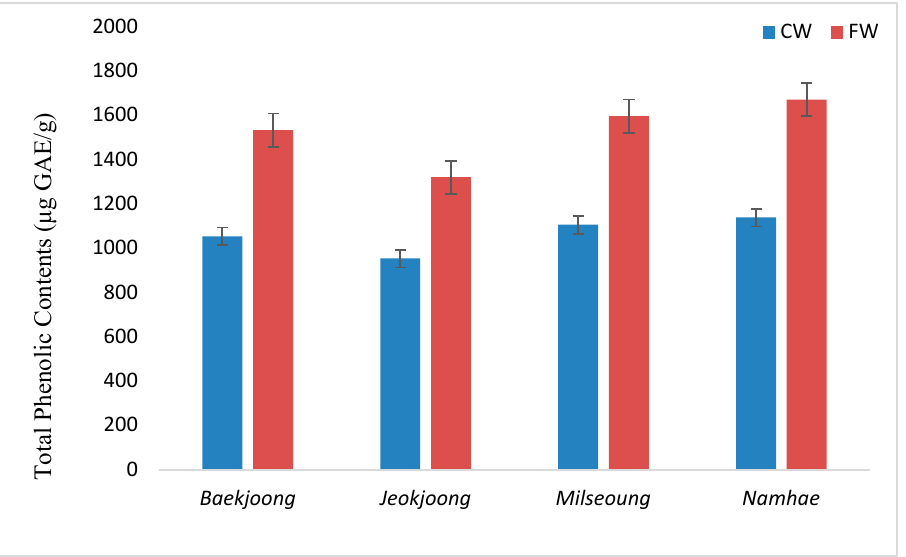
Figure 2. Total phenolic contents of cooked wheat and fermented wheat. Error bars (mean ± SD) represent significant differences among the treatments. The data were analyzed with a one-way ANOVA followed by Duncan multiple range tests ( p < 0.05). CW: cooked wheat, FW: fermented wheat.